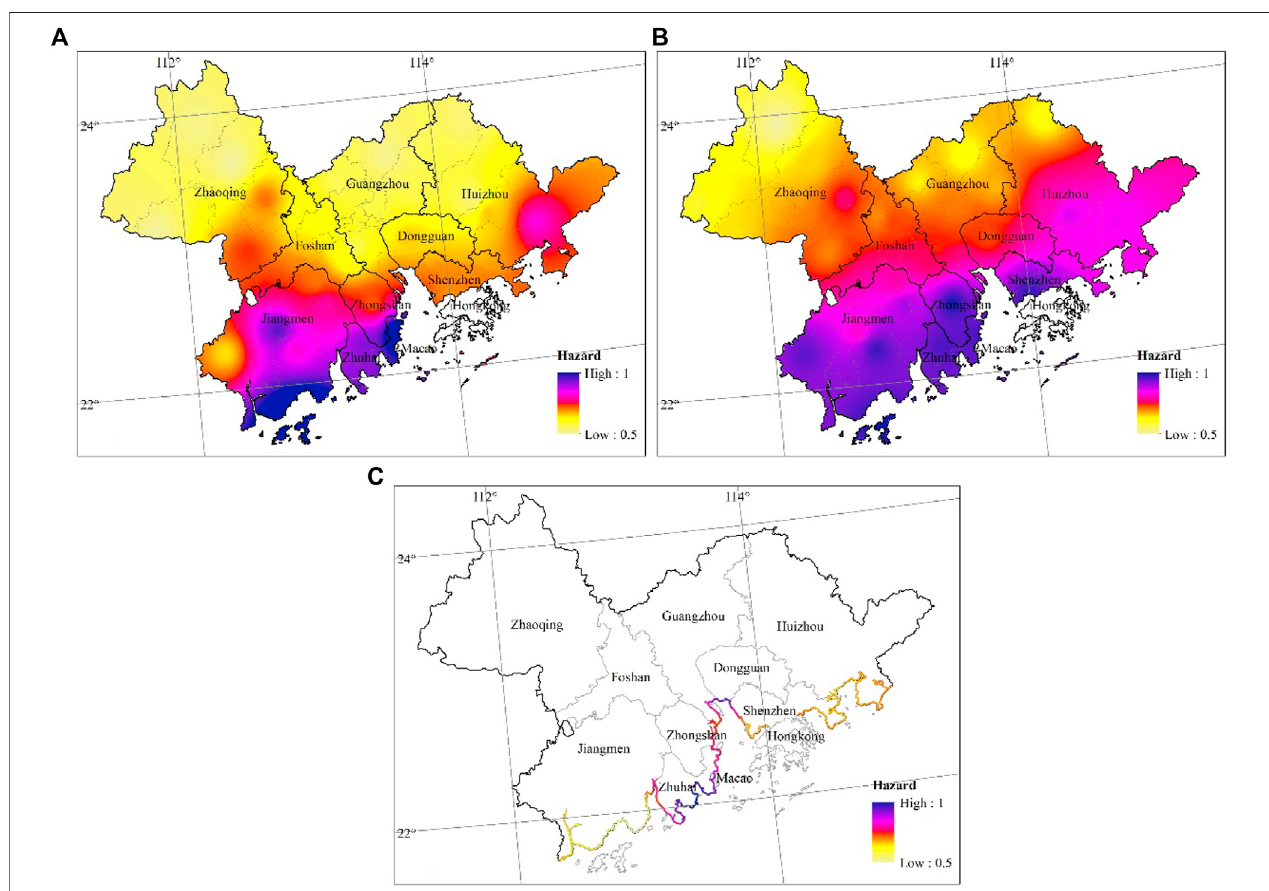
FIGURE5| Spatialdistributionsofhazardindexesof (A) typhoon – gale, (B) typhoon – rainstorm,and (C) typhoon – stormsurgedisasterchainsintheGBAfrom2009 to 2020.